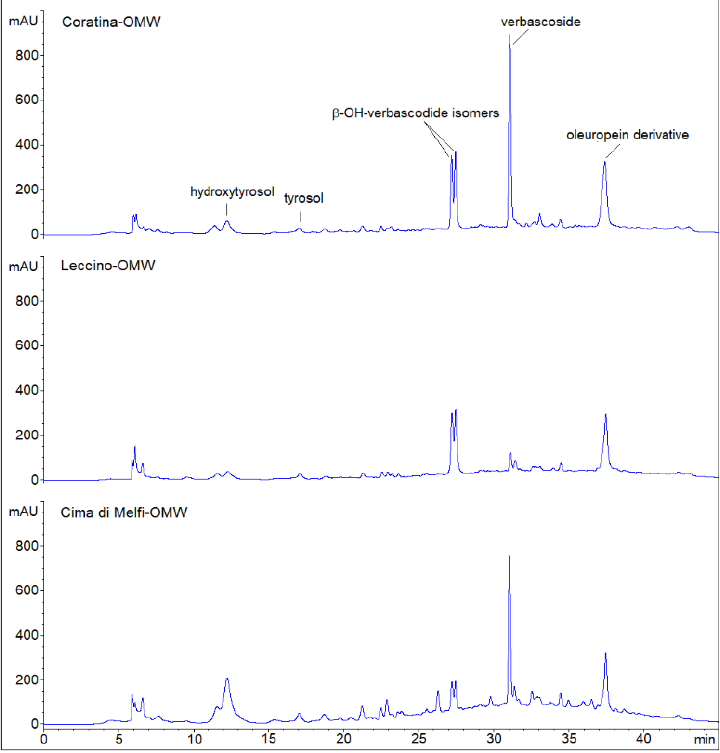
Figure 7. Phenolic profiles (HPLC chromatograms) of olive mill wastewater (OMW) resulting from olive oil production of Leccino , Coratina and Cima di Melfi cultivars. Peaks have been putatively assigned on the basis of retention time values (min) and by comparing them with literature data and UV spectra (280 nm).